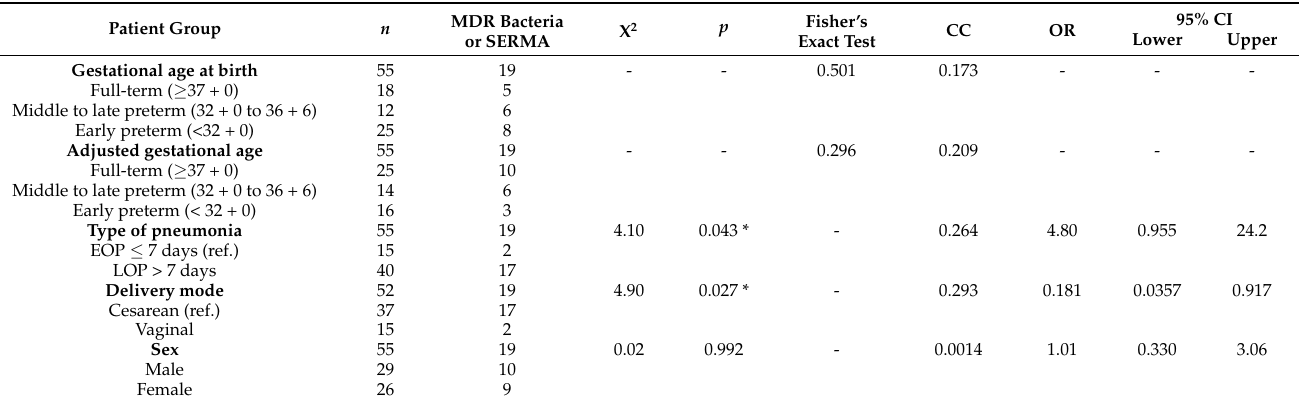
Table 2. Correlation between neonatal risk factors and colonization or infection with MDR bacteria /SERMA in neonates affected by